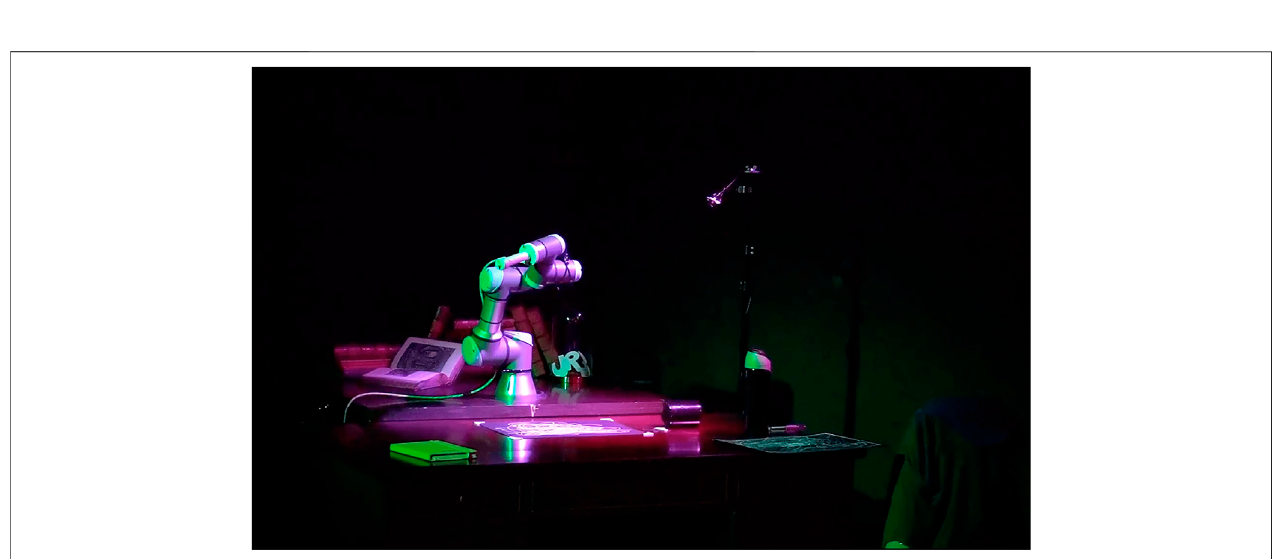
FIGURE 12 | The robot after performing animation of hitting a cup from the table during the If/Then performance at the museum. EMCAR was used to record the animations before the performance and replay them in the cue moments.